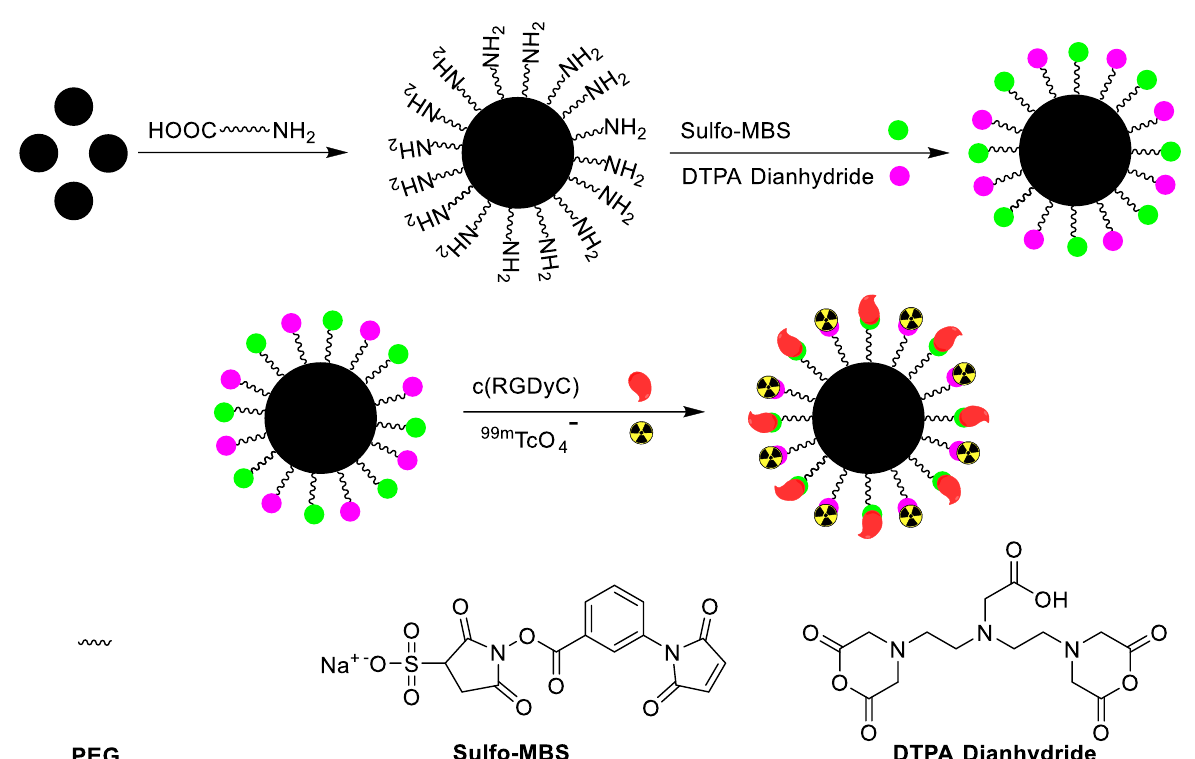
Figure 3. Procedure for the synthesis of c(RGDyC) decorated iron oxide nanoparticles and radiolabeling with 99m Tc [31].